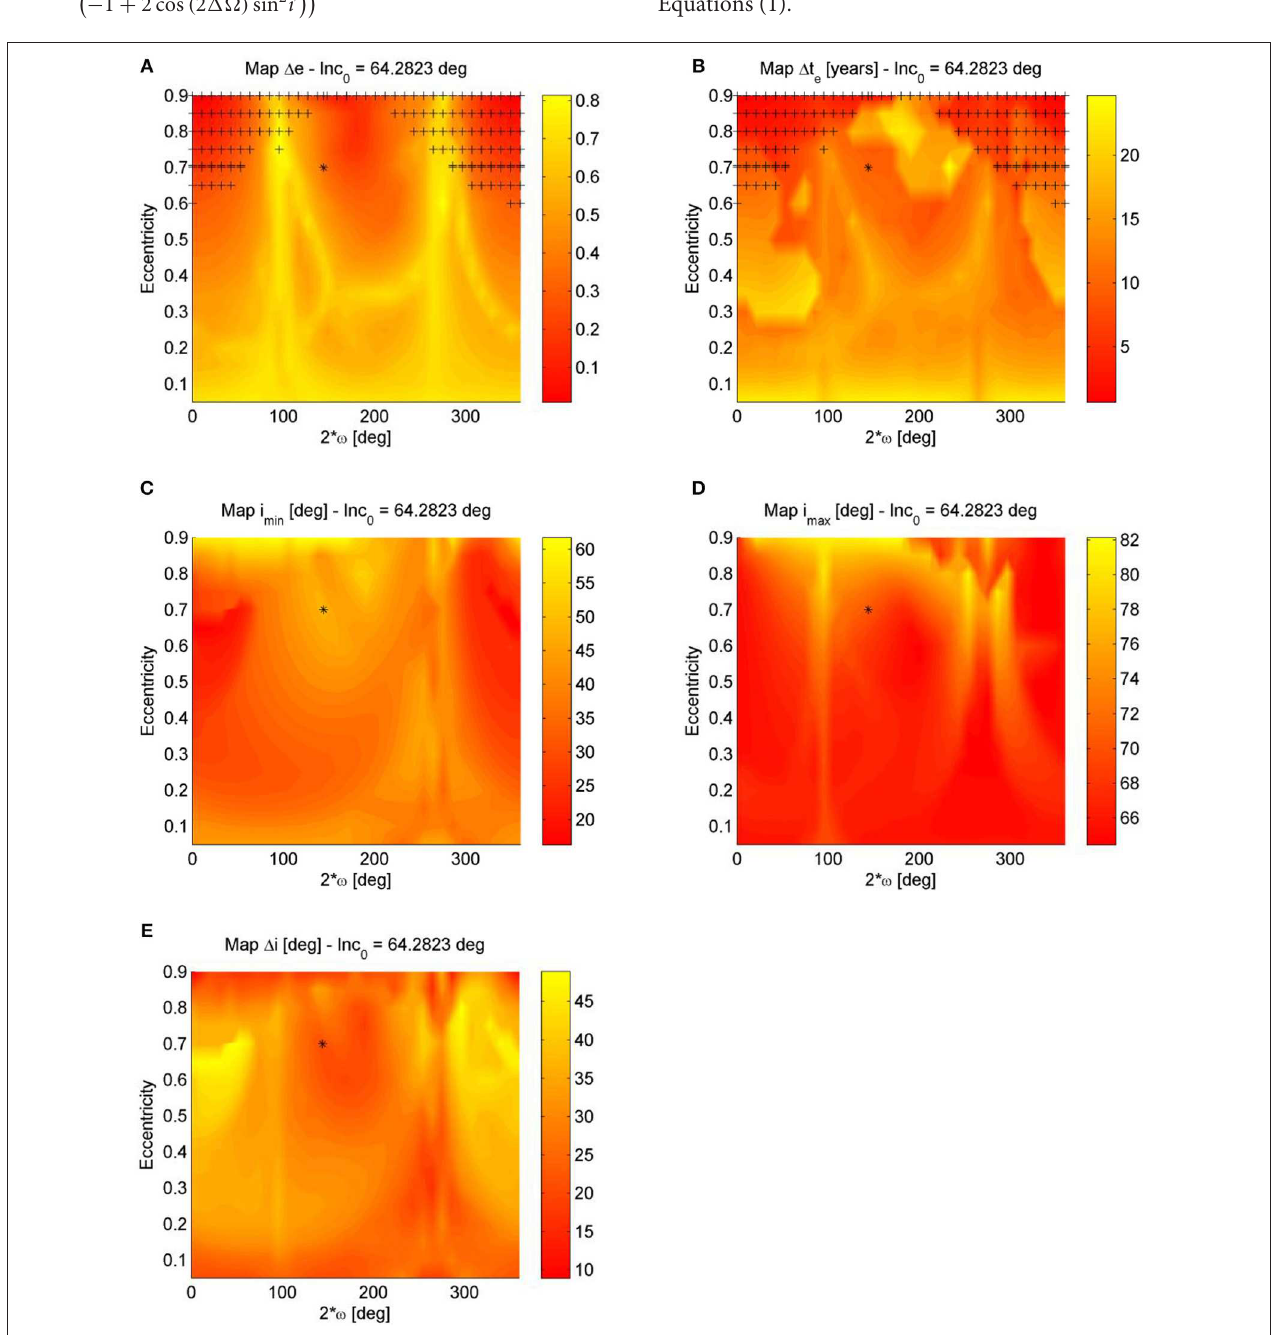
FIGURE 6 | Luni-solar zonal maps for semi-major axis of XMM Newton orbit a + map. The initial inclination and the argument of the perigee are measured with respect to the Moon’s plane.